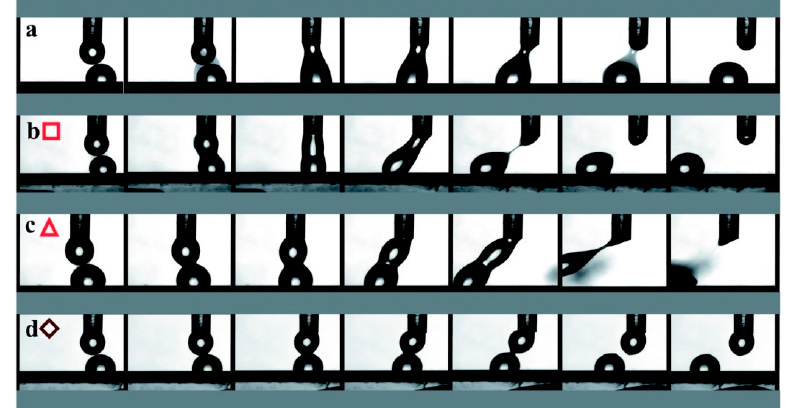
Figure 12. Photos of the hyaluronic acid drops in contact with each other. From left to right: the moment before the touching point, contact point, recession, disassociation. ( a ) 132 kDa, 20.0 mg / mL: ( b ) 1500 kDa 10.0 mg / mL, ( c ) 1500 kDa 20.0 mg / mL, ( d ) 2000 kDa 30 mg / mL. Reproduced from [69], with permission